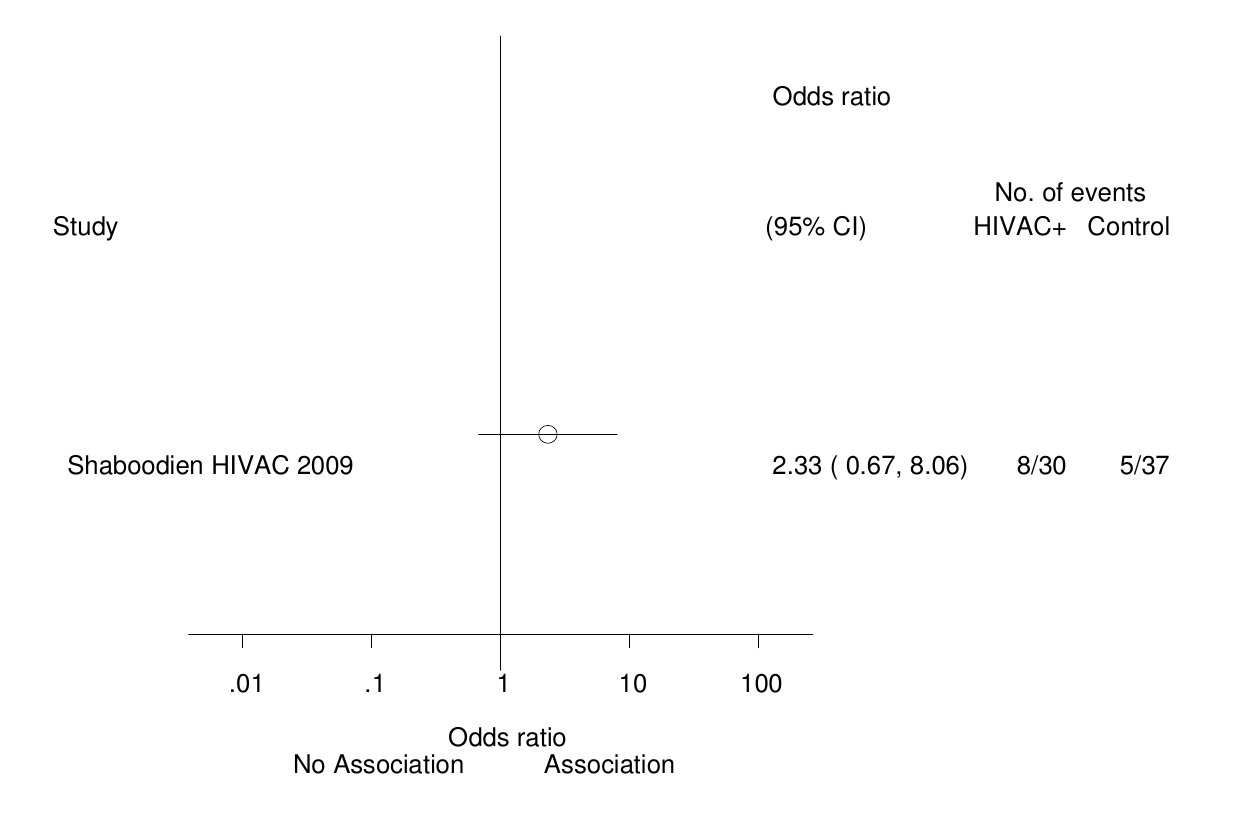
Figure 1 Forest plot indicating the frequency of the mtDNA T16189C variant with a homopolymeric C-tract in HIV- associated cardiomyopathy patients and HIV-positive controls